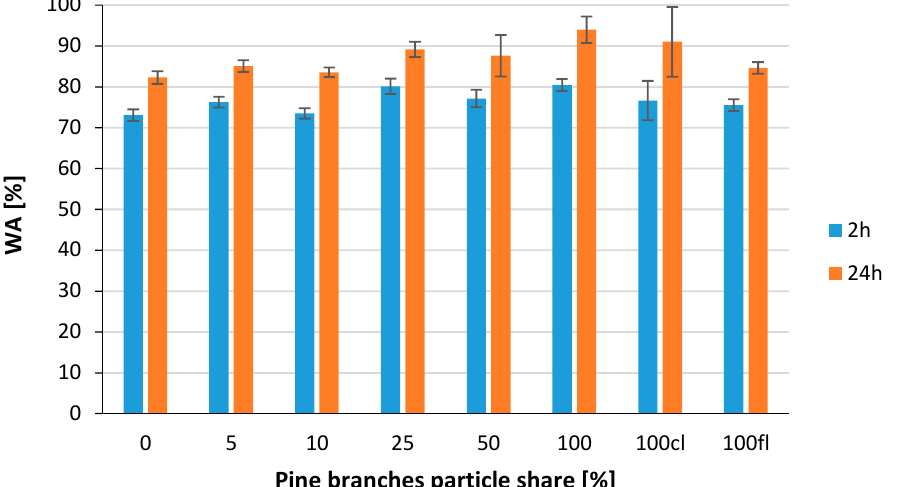
Figure 9. Water absorption of tested